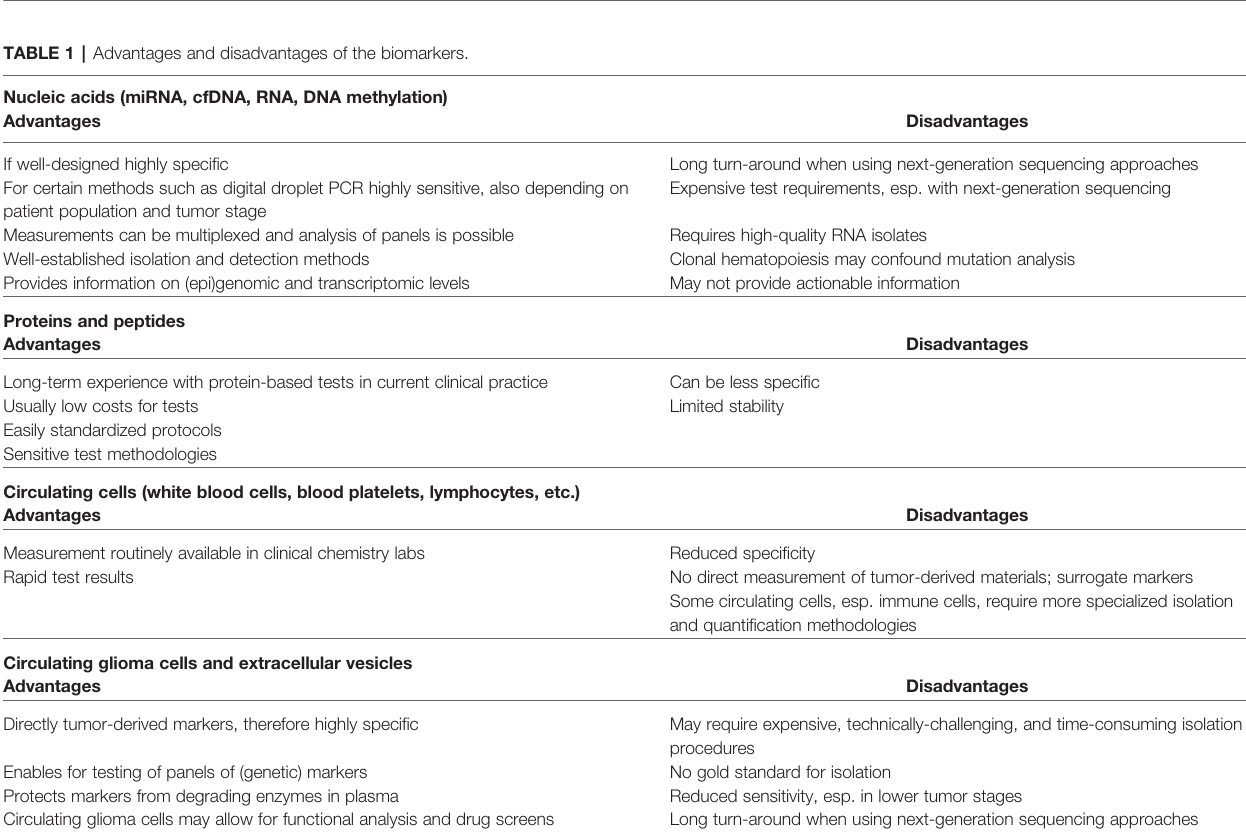
FIGURE 4 | Correlation of blood-based biomarkers in patients with glioma with seminal events in tumorigenesis. Blood biomarkers in glioma patients are implicated in the molecular pathways as detailed by Hanahan and Weinberg (321). Markers colored in green were mostly found to be increased in the circulation of glioma patients compared to healthy individuals, and in glioma patients with more malignant tumors compared to patients with less malignant tumors. Markers that were inversely correlated were colored in red. Markers without color were found to be either signi fi cantly increased or decreased in the formerly mentioned groups. The abbreviation “ DC ” indicates dendritic cells and “ iDC ” indicates immature dendritic cells. Adapted from “ Hallmarks of Cancer: Circle ” , by BioRender.com (2021). Retrieved from: https://app.biorender.com/biorender-templates.